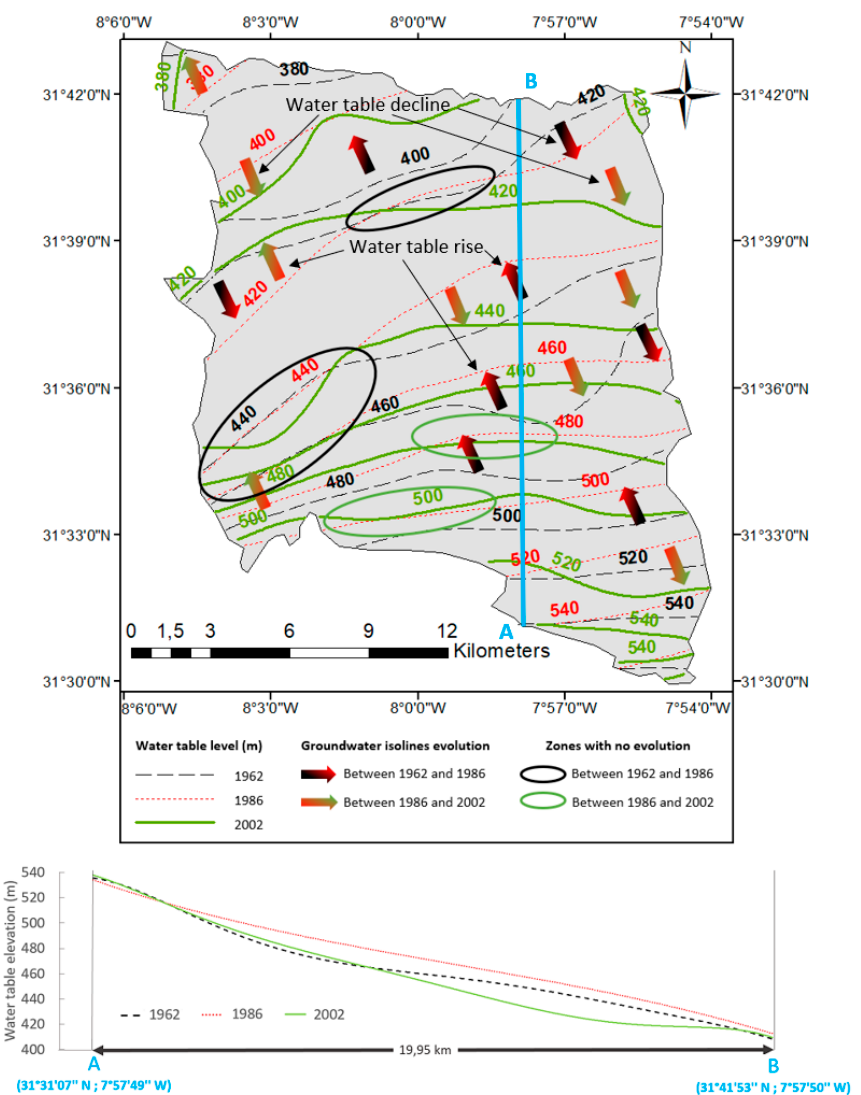
Figure 5. Water table trend in 1962, 1986 and 2002 and cross-section (N-S) indicating the average groundwater table . As shown in Figure 5, the majority of black–red arrows point to the south, while the opposite is seen for the red–green arrows. This indicates that the water table increased